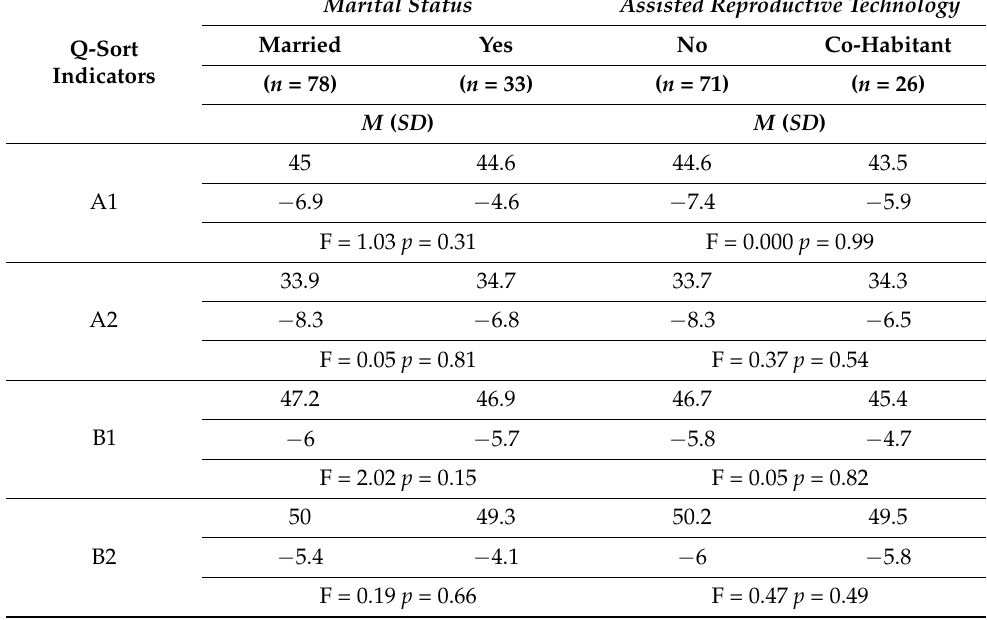
Table 10. Maternal competence (Q-sort scores) at the time of home (T2) in relation to marital status and medically assisted procreation (MANOVA) ( n =